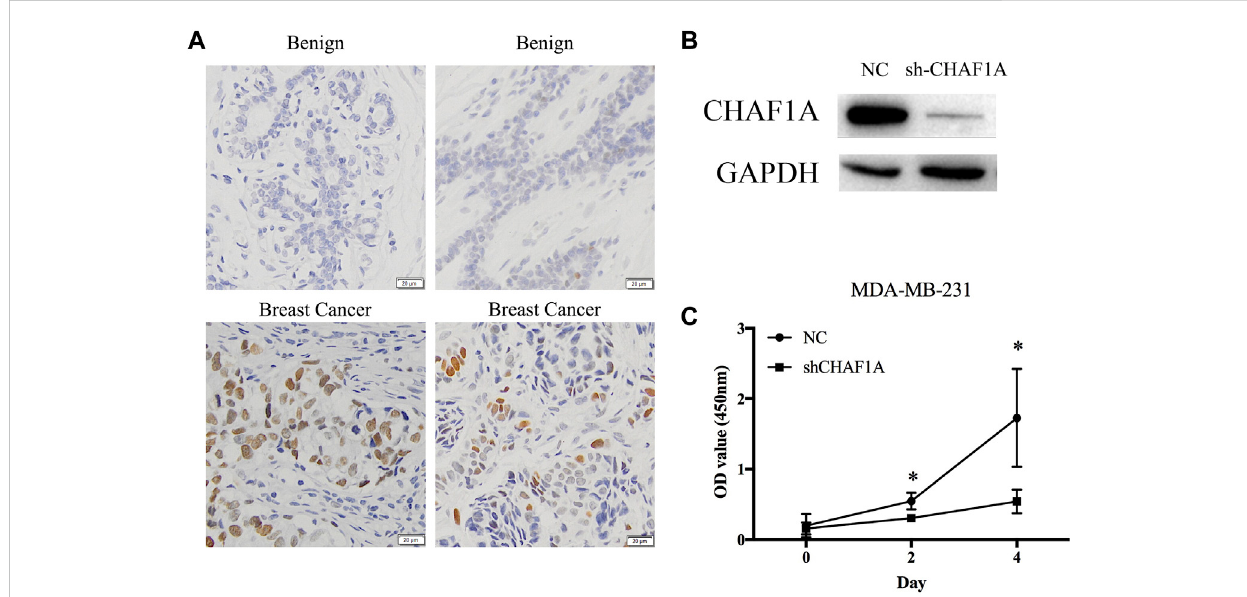
FIGURE 6 CHAF1A highly expressed in breast cancer tissues and inhibition of cell proliferation by silencing of CHAF1A. (A) Higher expression of CHAF1A was con fi rmed in clinical breast cancer tissues compared with normal tissues by IHC. (B) The expression of CHAF1A was dramatically downregulated using shRNA of CHAF1A in MDA-MB-231 cells. (C) Cell proliferation of MDA-MB-231 cells was signi fi cantly inhibited after CHAF1A